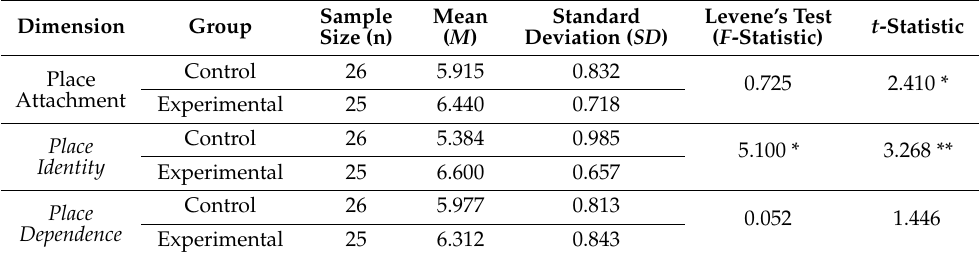
Table 3. Summary of the t -test results of the experimental and control groups’ place attachment, place identity, and place